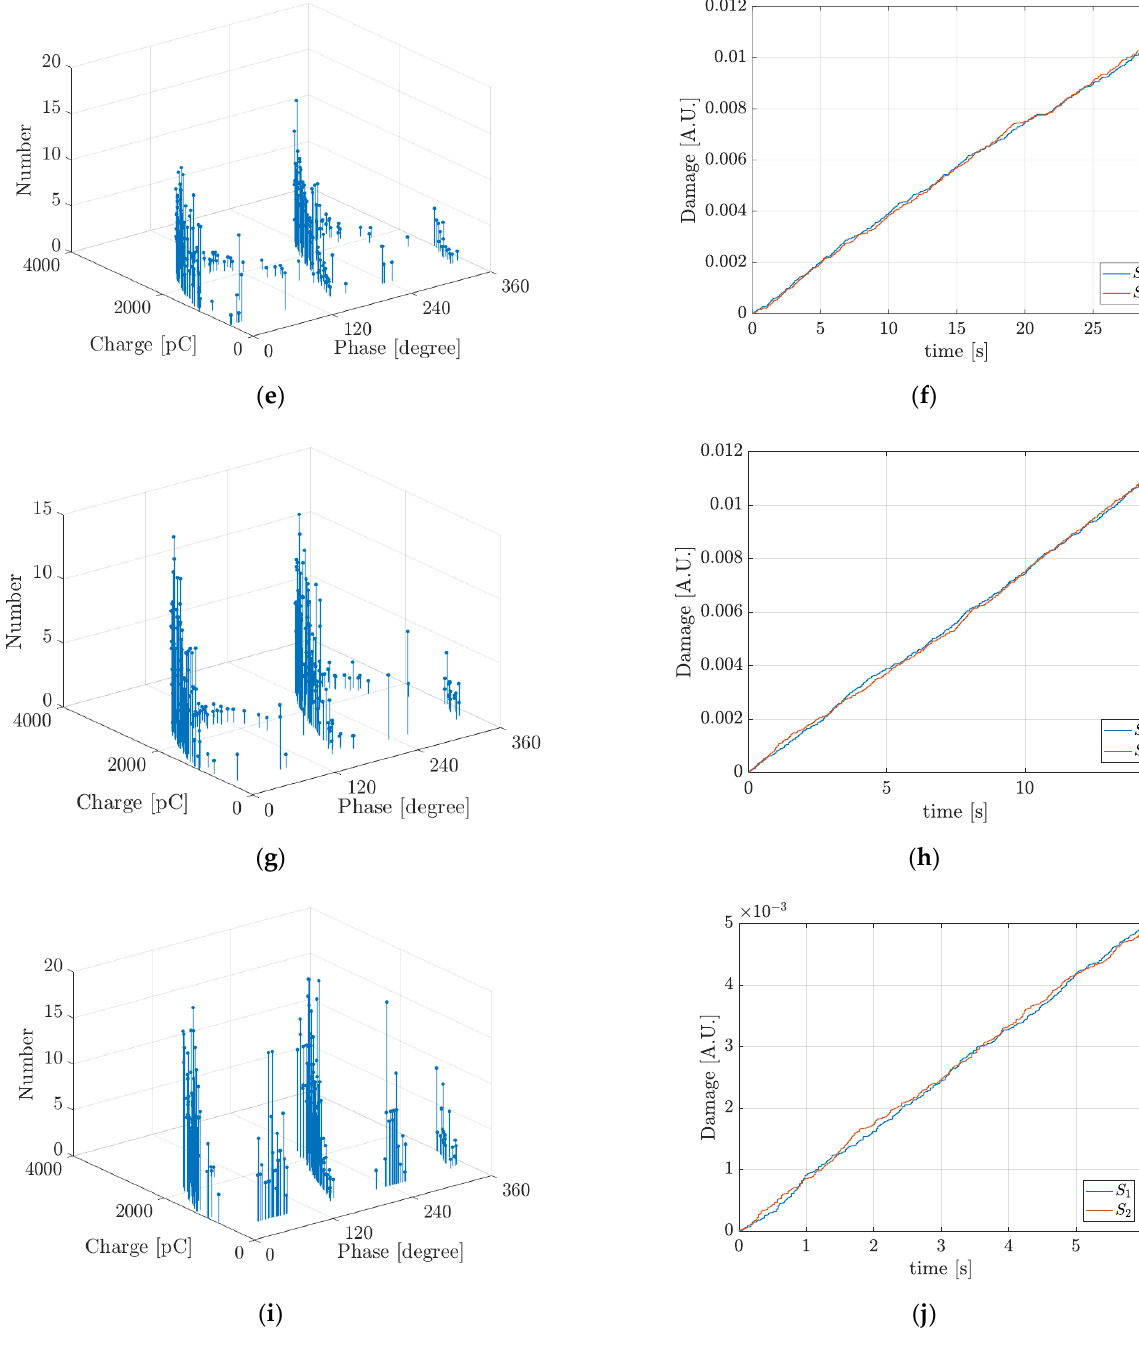
Figure 7. Typical simulation results of PRPD pattern and accumulated damage function for the five applied voltage frequencies in the third case study: ( a ) and ( b ) 1 Hz; ( c ) and ( d ) 5 Hz; ( e ) and ( f ) 10 Hz; ( g ) and ( h ) 20 Hz and ( i ) and ( j ) 50 Hz.